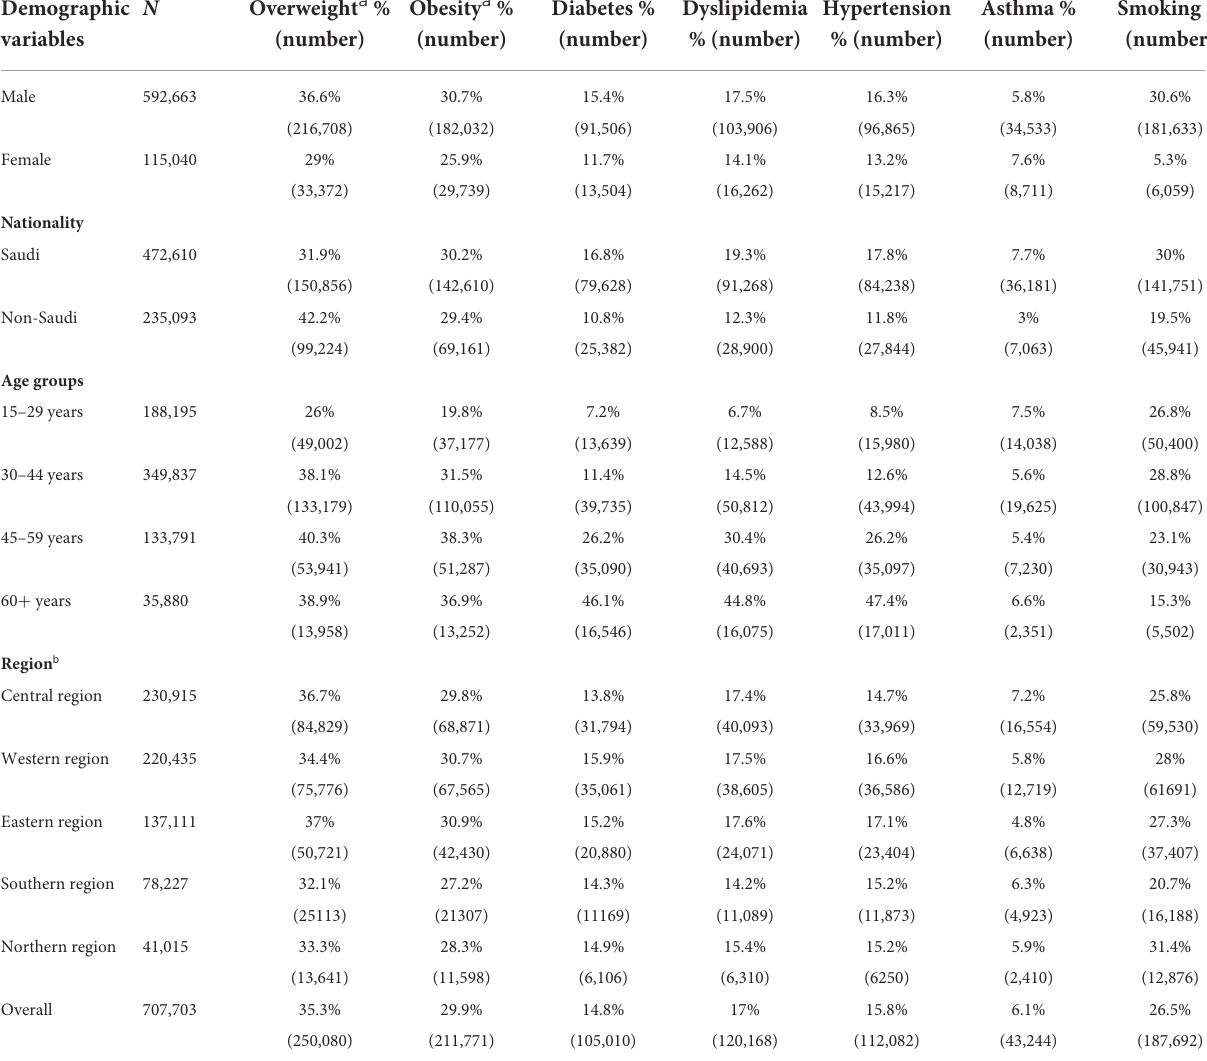
TABLE 2 Prevalence of noncommuncable diseases and their risk factors among Absher survey respondents